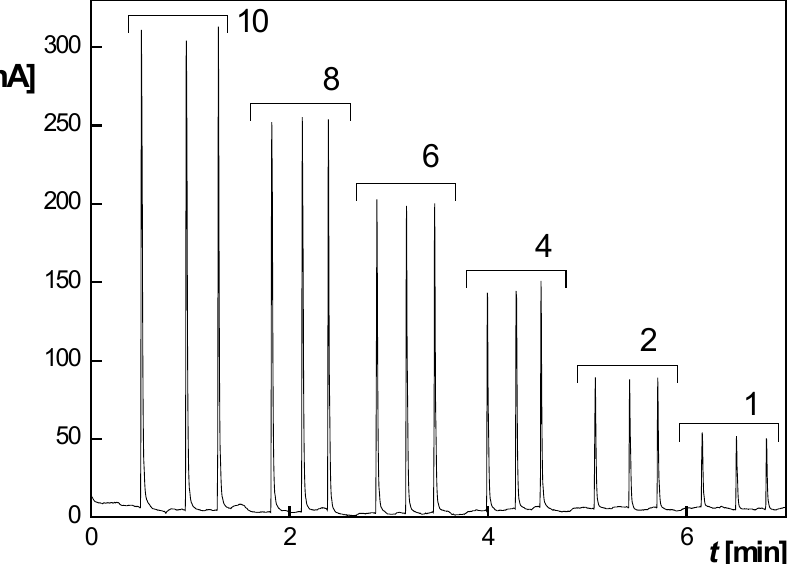
= +1.3 V, injected 20 µL of DET